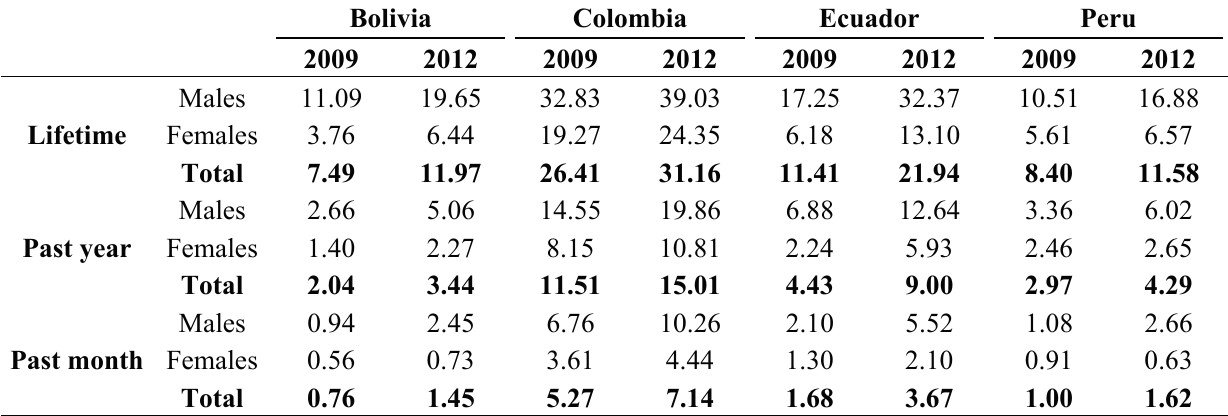
Table 1. Prevalence of marijuana use in Andean countries *